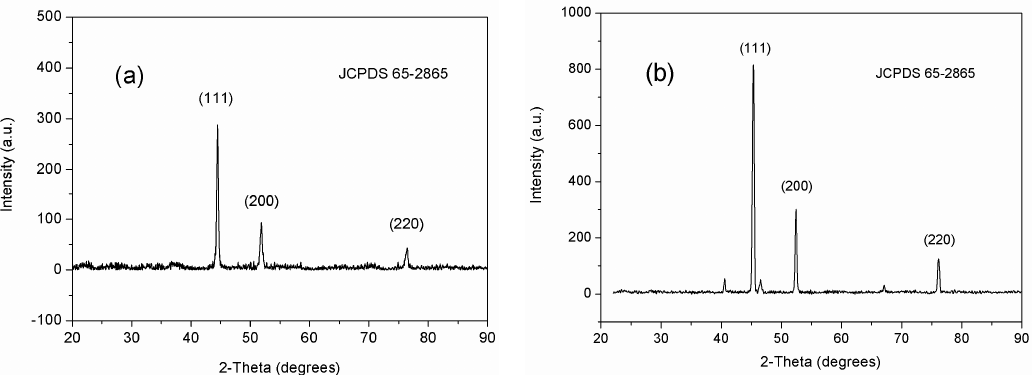
Figure 4. Small-angle XRD diffraction spectrum of the ( a ) flower-like Ni/Al 2 O 3 /Ni film and ( b ) grain-like Ni/Al 2 O 3 /Ni film.